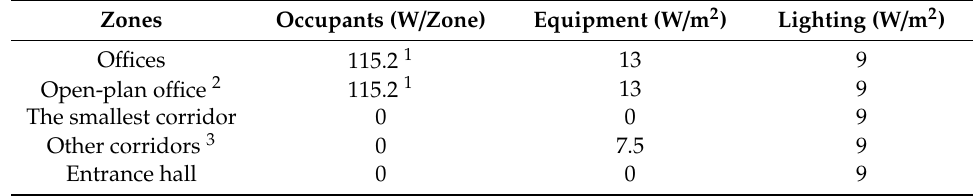
Table 7. The internal gains from di ff erent sources in di ff erent zones of the modelled floor.